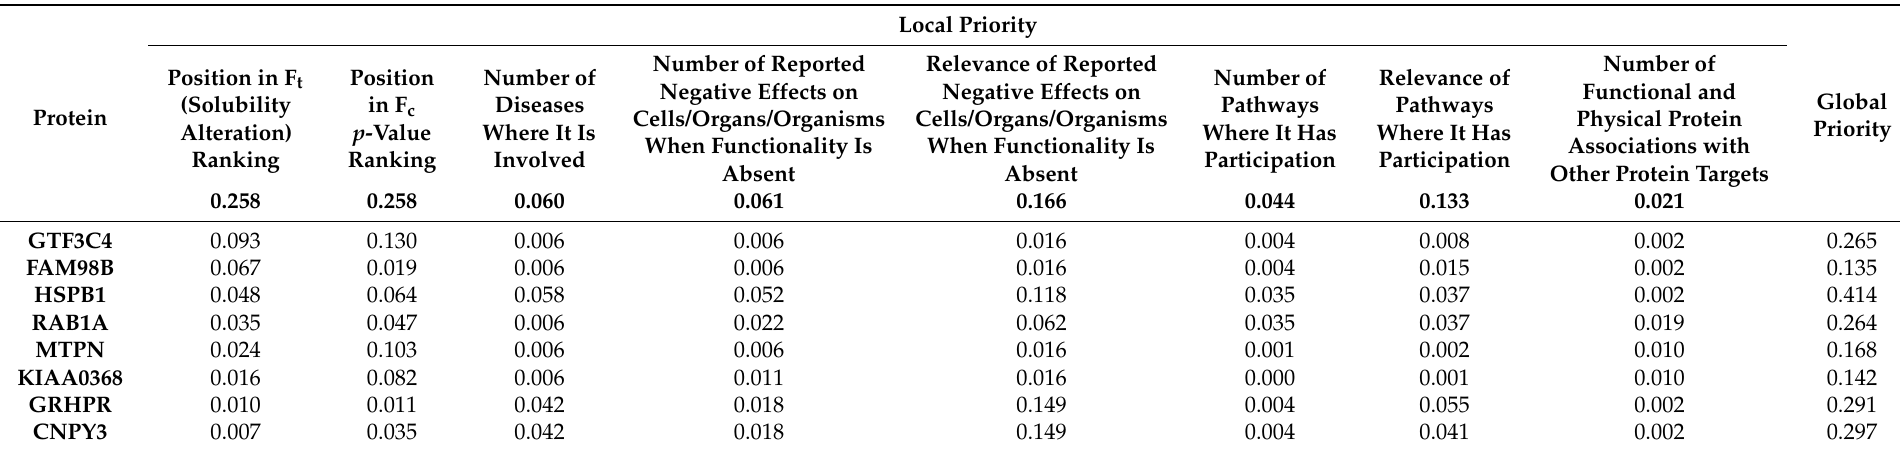
Table 4. Local priority for each criterion and global priority of the protein targets (alternatives). The Criteria priority vector is shown in bold.